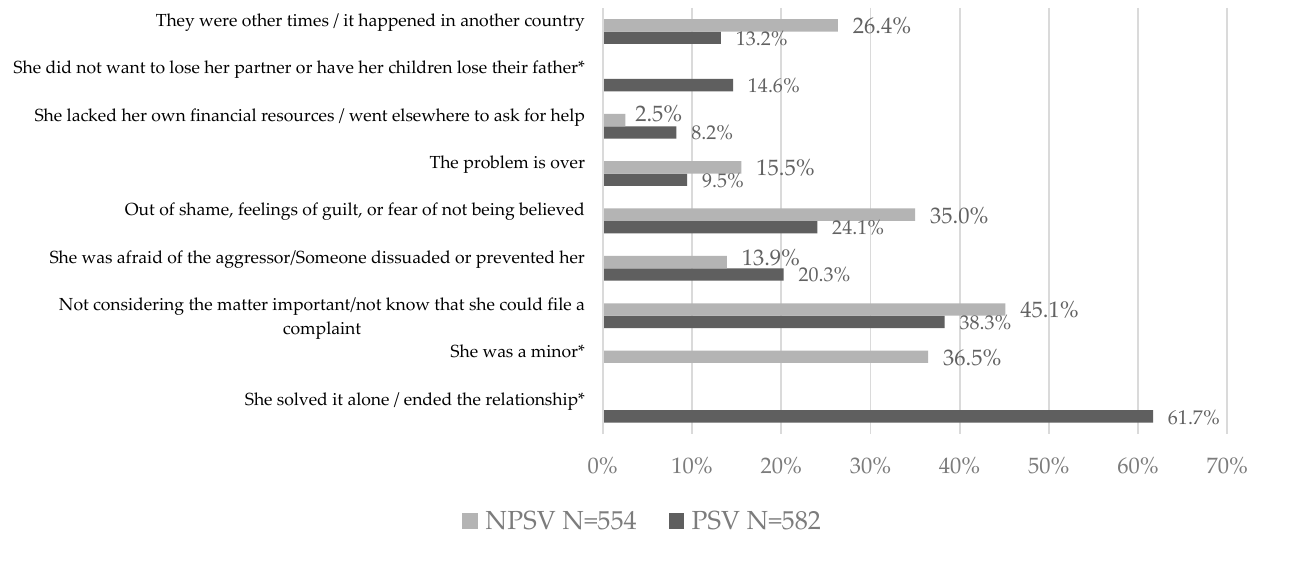
Figure 3. Reasons for not filing a police report or judicial complaint of PSV and NPSV. * Some answers do not apply for a certain group of women, so the data is not shown.